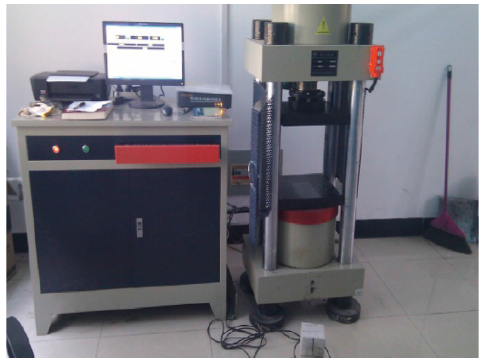
Figure 7: Compression machine and data acquisition.